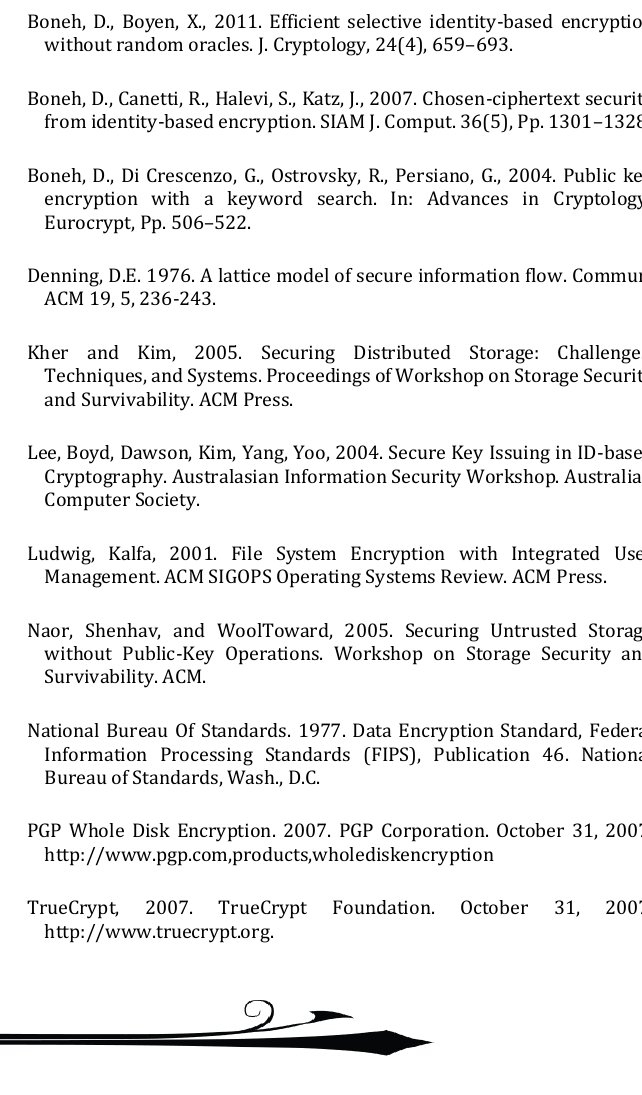
Figure 2 - Simple Operation of Retrieving Encrypted File The